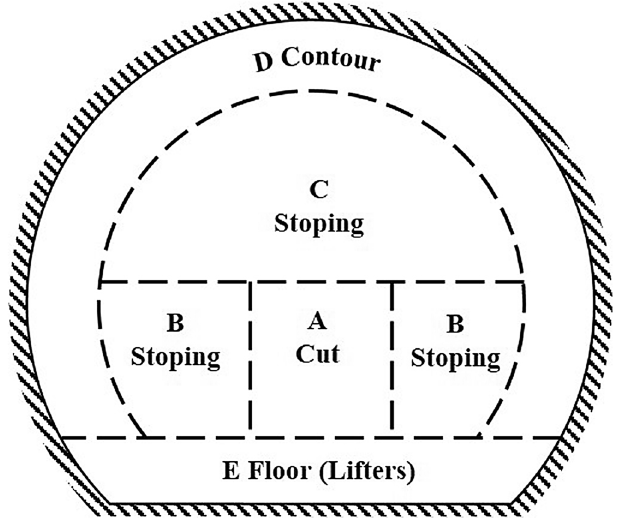
Figure 6. Zones in tunnel blasting 9 .